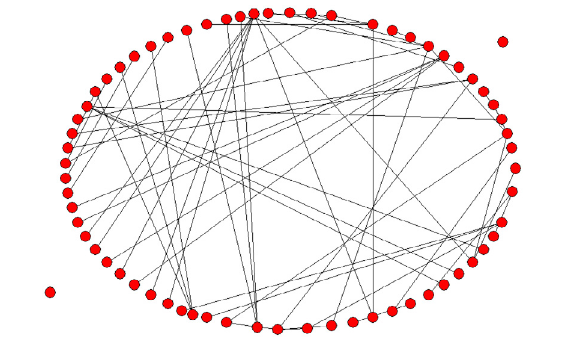
Figure 1: Network of interactions